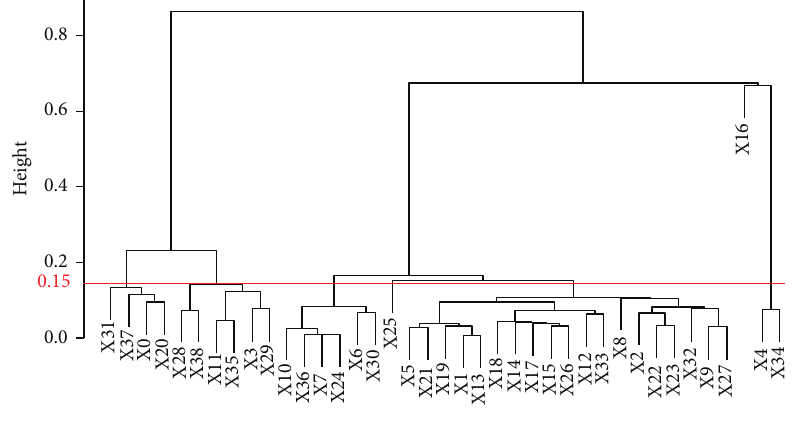
Figure 9: Hierarchical clustering demo.